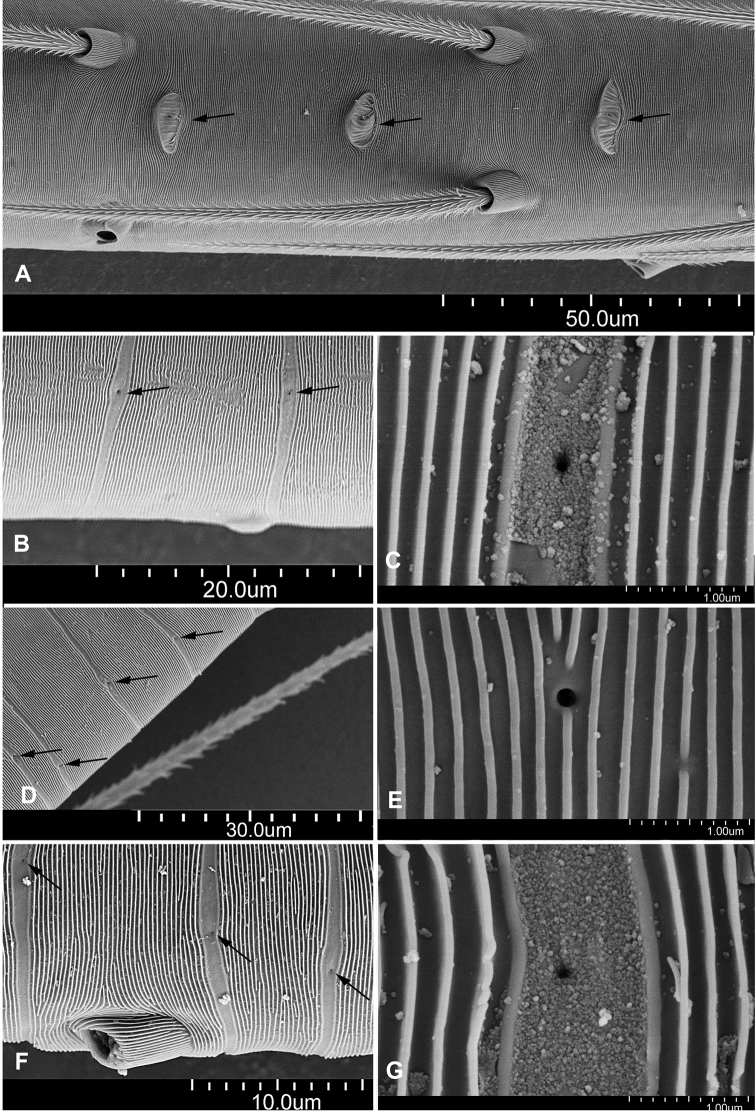
Tibial glands on leg III of telemids in East and Southeast Asia (Zhuanlema gen. nov. is not included). ATelema
guihuaBPinelema
bailongensisCMekonglema
xinpingi comb. nov. DSiamlema
changhai sp. nov. ESundalema
anguina comb. nov. FApneumonella
jacobsoniGTelemofila
samosirensis.